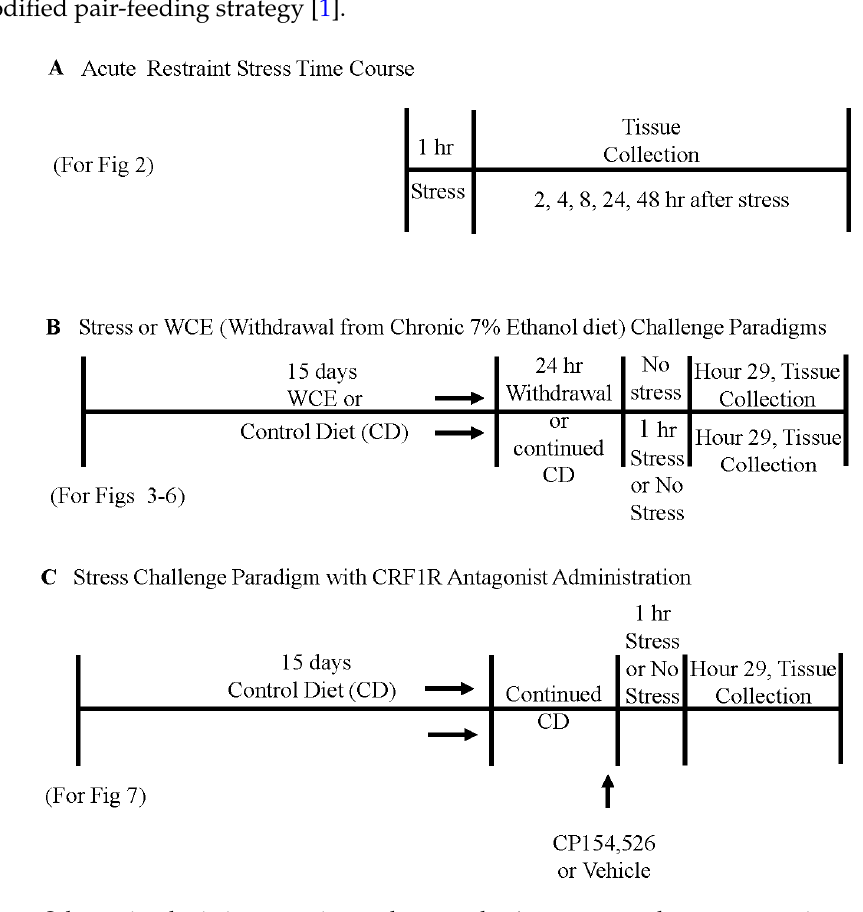
Figure 1. Schematics depicting experimental protocols. A : represents the acute restraint stress time course, while B : represents the stress and withdrawal from chronic alcohol and C : represents the CRF1R antagonist study.